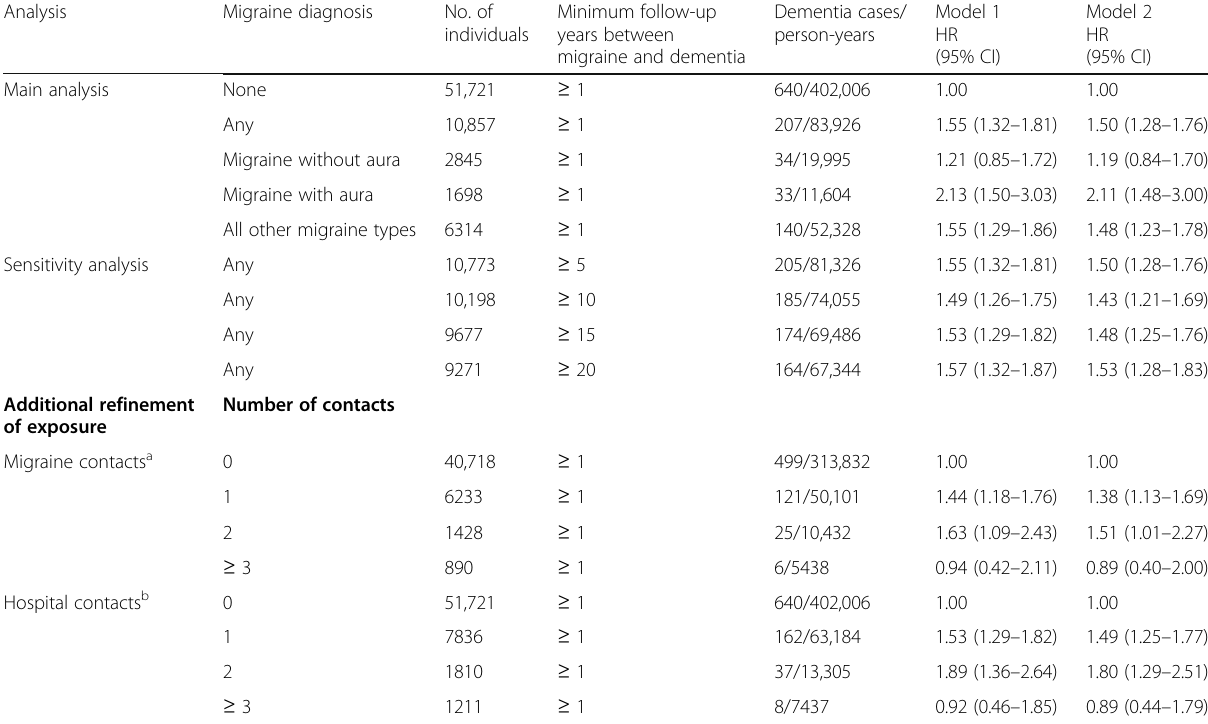
Table 3 Hazard rate ratios of dementia associated with migraine diagnoses ( N = 62,578)